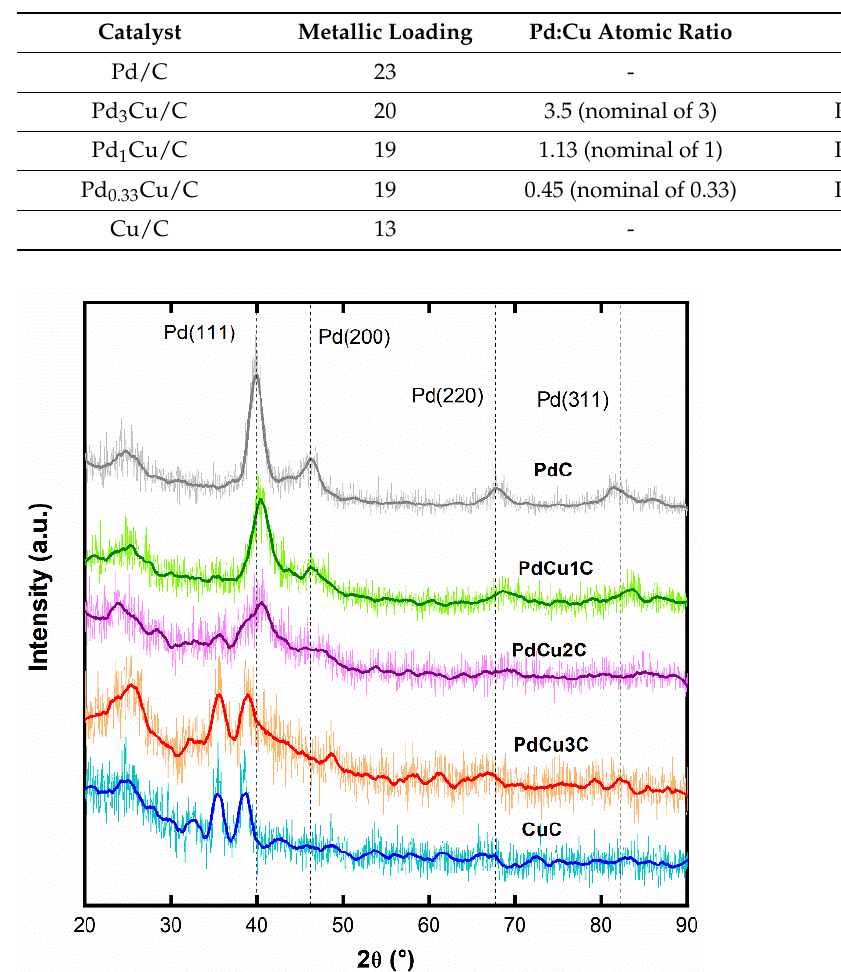
Table 1. Nominal and actual metal wt.% loading and Pd:Cu atomic ratio for the different electrocatalysts.